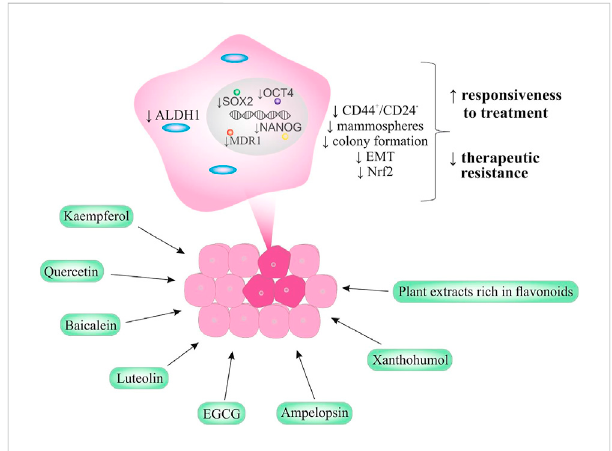
Flavonoids targeting BCSCs (dark pink) — Potential to combat therapeutic